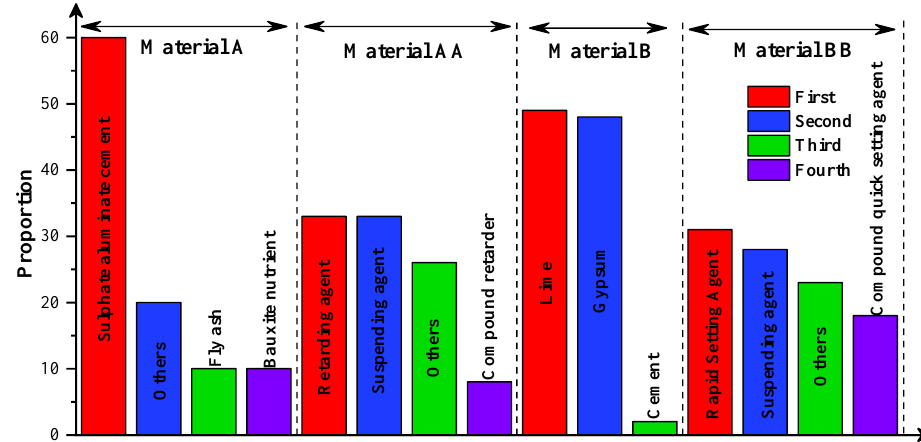
Figure 20. Percentages of the different materials high-water backfill material.